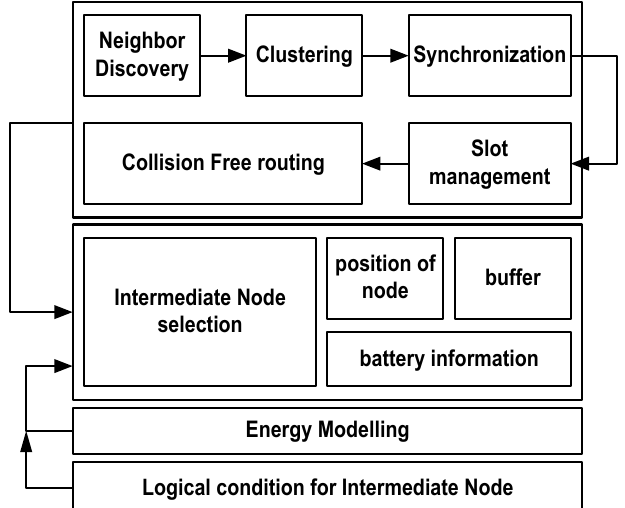
Figure 2. Proposed Schematic Architecture.